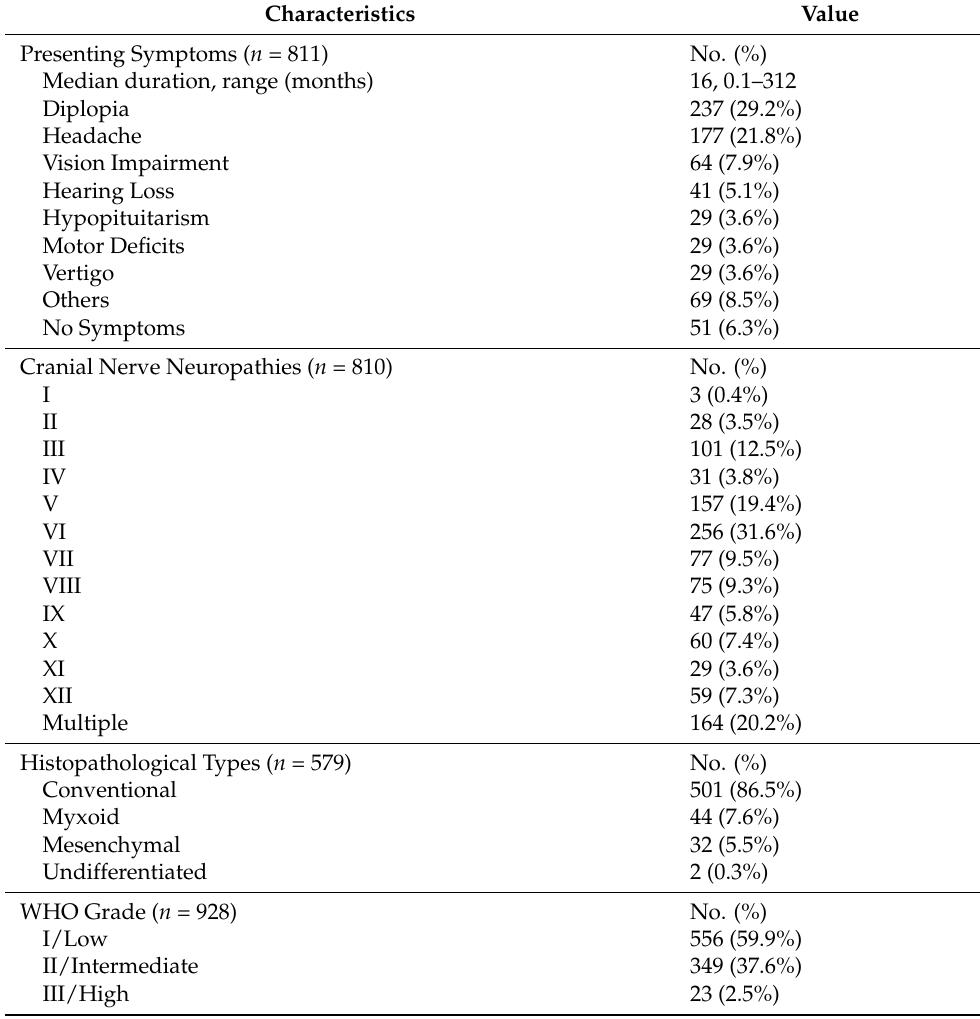
Table 2. Summary of clinical characteristics of all pooled